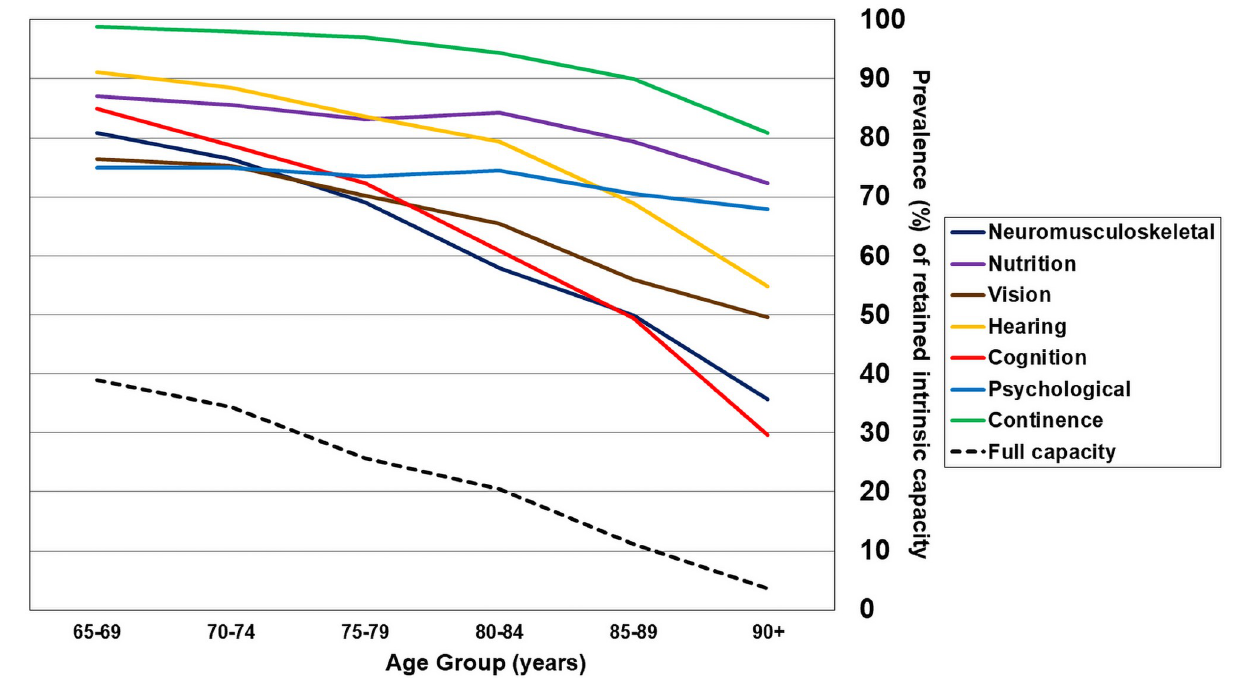
Fig 1. Prevalence (percent) of retained intrinsic capacity, by age group.